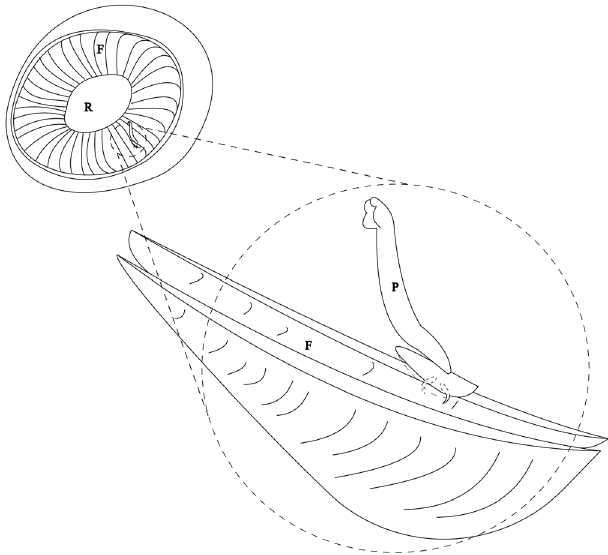
Figure 3. Mode of attachment of Holocephalocotyle monstrosae